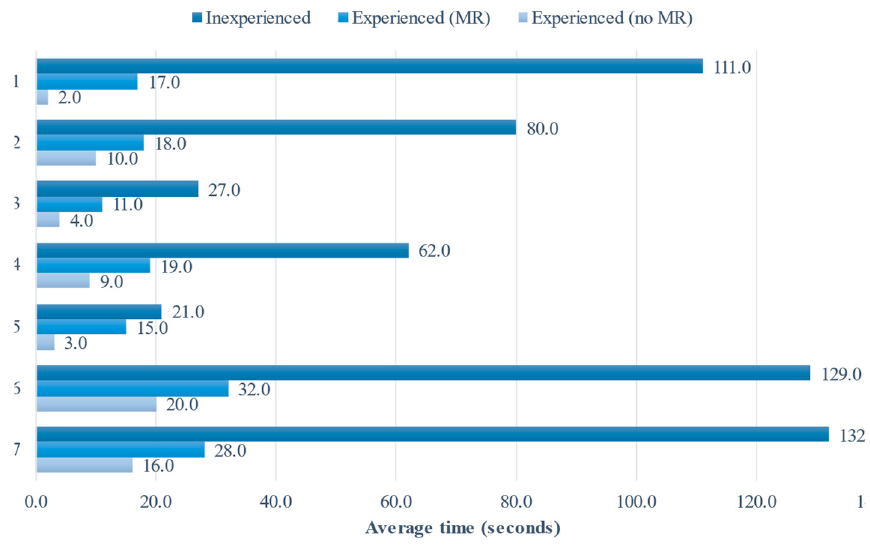
Figure 15. The average times for each assembly step. The times are collected for each step and sub-step for an experienced user with and without guidance, and for inexperienced users using the MR app.